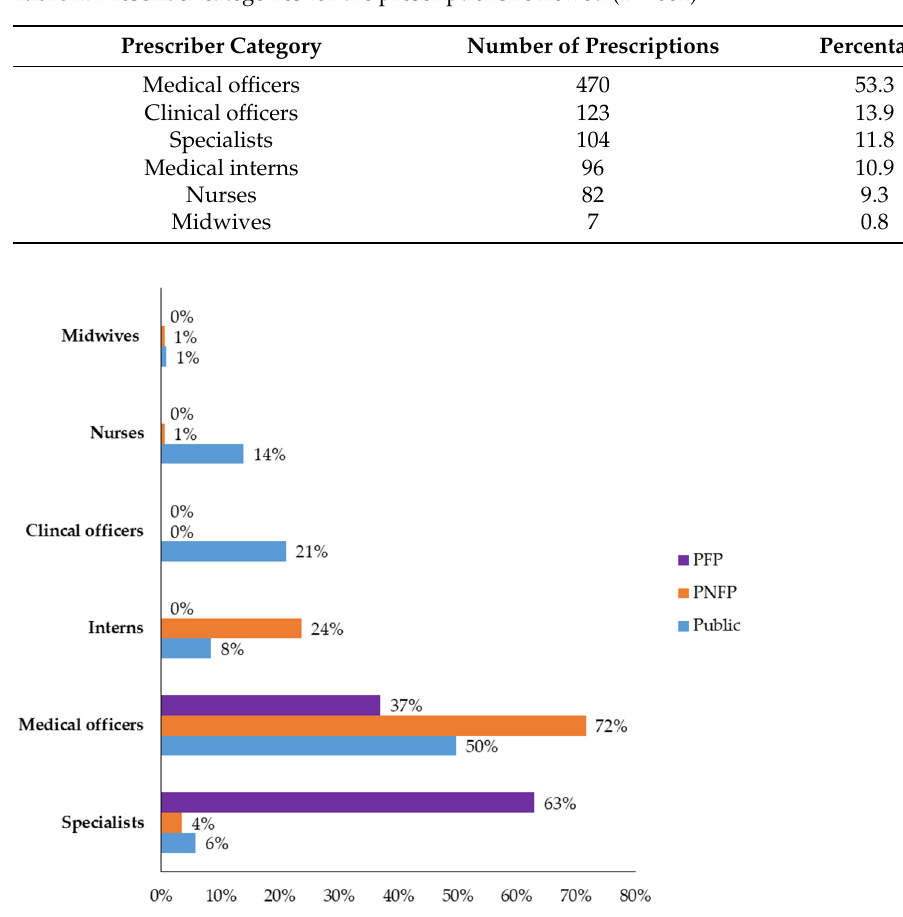
Figure 1. Prescriber categories at the nine health facilities (N =